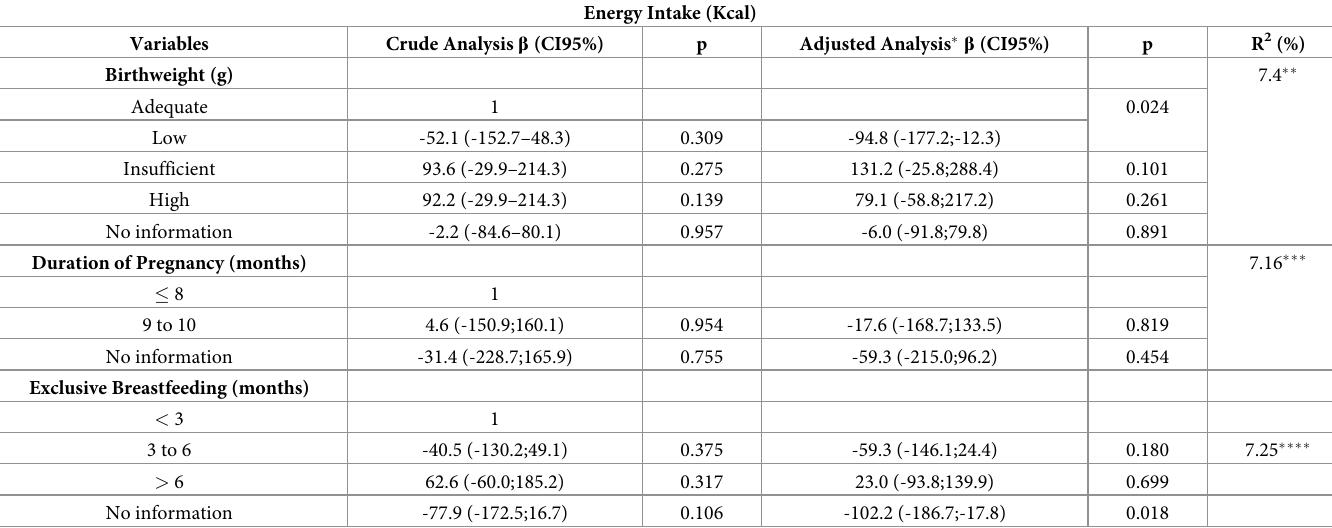
Table 2. Multiple linear regression between biological and behavioral factors in early life and energy intake in Brazilian adolescents, ERICA